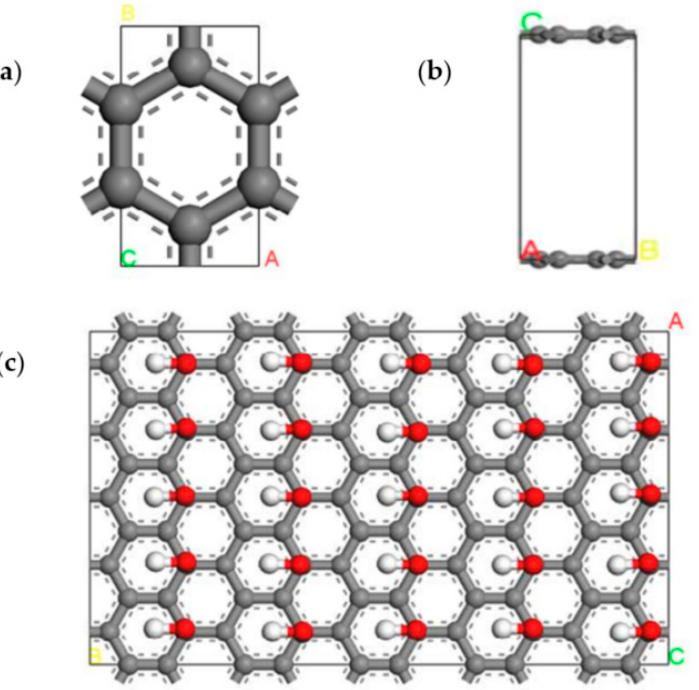
Figure 6. ( a ) The top view; ( b ) the side view of graphite, and ( c ) a hydroxyl ‐ modified graphite